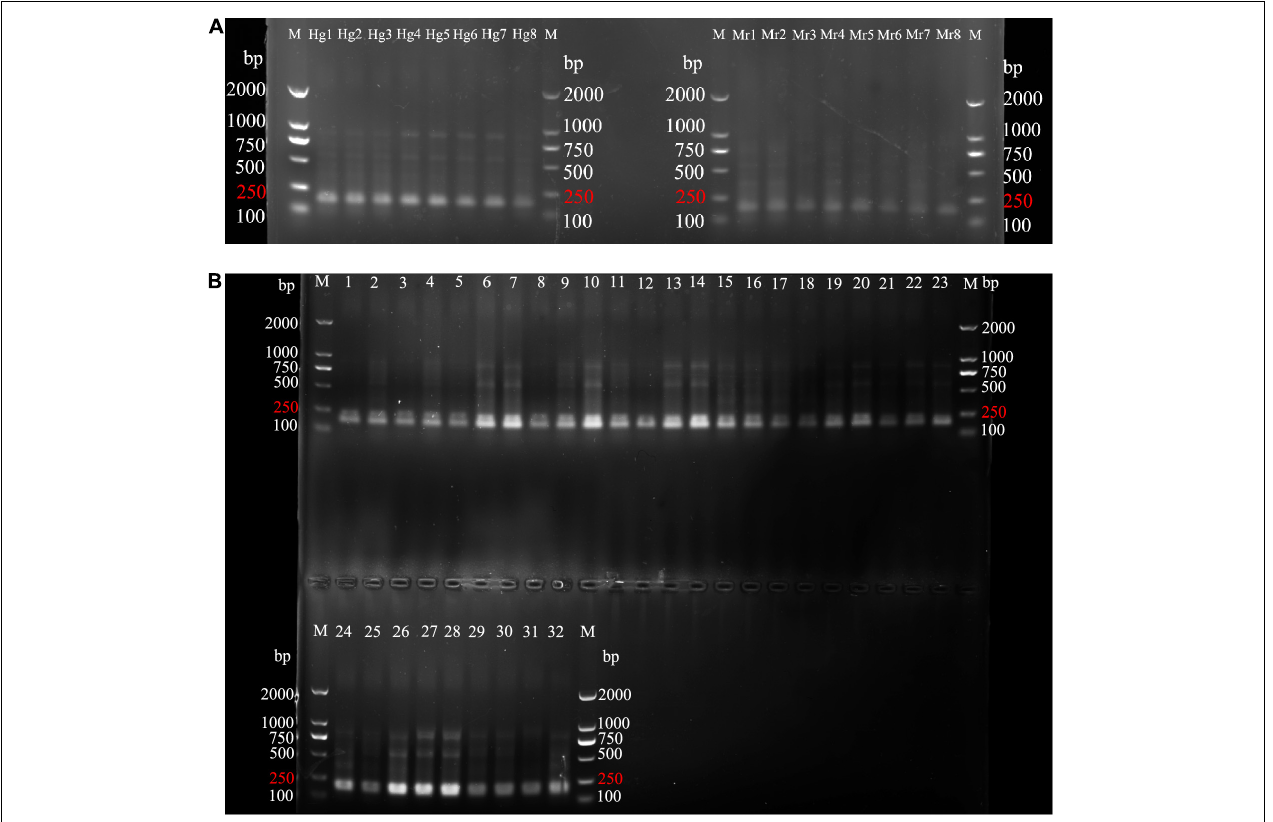
FIGURE 3 | PCR product agarose gel results for 8 genuine and 40 counterfeit samples using HG. (A) Agarose gel electrophoresis of 8 genuine samples (Hg1-Hg8) and 8 M. reevesii samples (Mr1-Mr8). (B) Agarose gel electrophoresis of HG4 with 32 counterfeit species samples (1–4: C. serpentina ; 5–6: C. galbinifrons ;